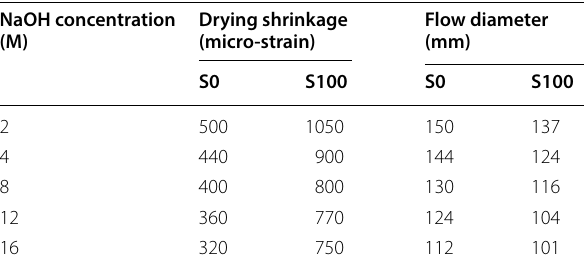
Table 3 Drying shrinkage and flow diameter of FA and GGBS geopolymer.